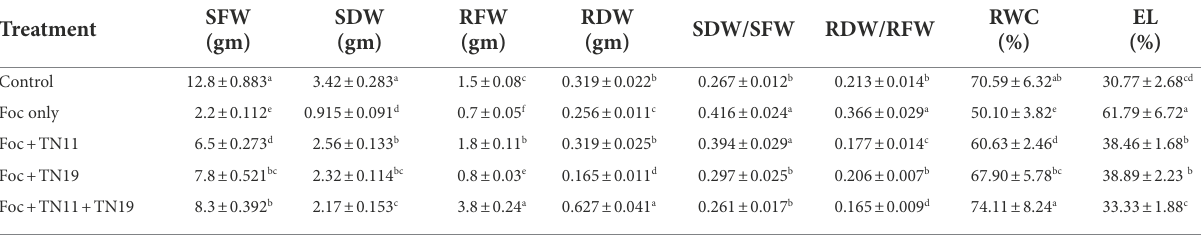
TABLE 2 Shoot fresh weight (SFW), shoot dry weight (SDW), root fresh weight (RFW), root dry weight (RDW), SDW/SFW ratio, RDW/RFW ratio, relative water content (RWC), and electrolyte leakage (EL), of chickpea plants under unprimed control, Foc challenged, Foc challenged + TN11